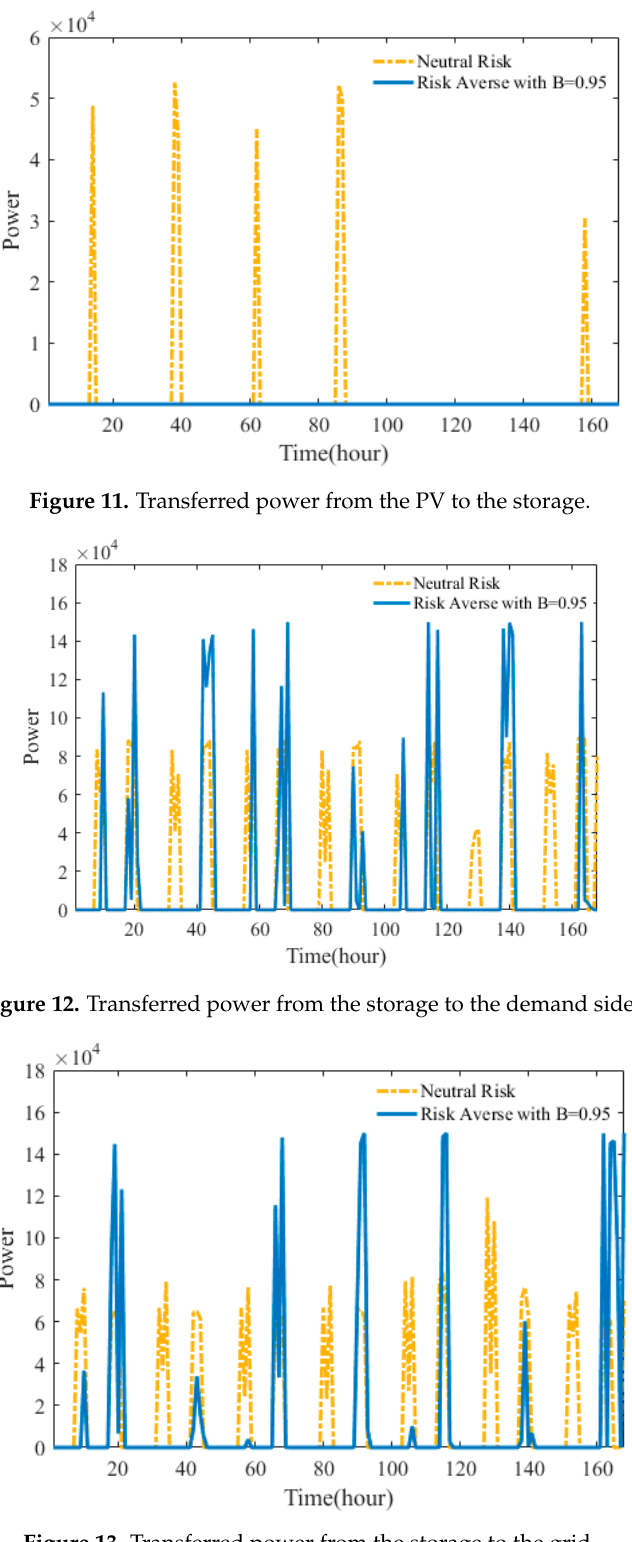
Figure 13. Transferred power from the storage to the grid.